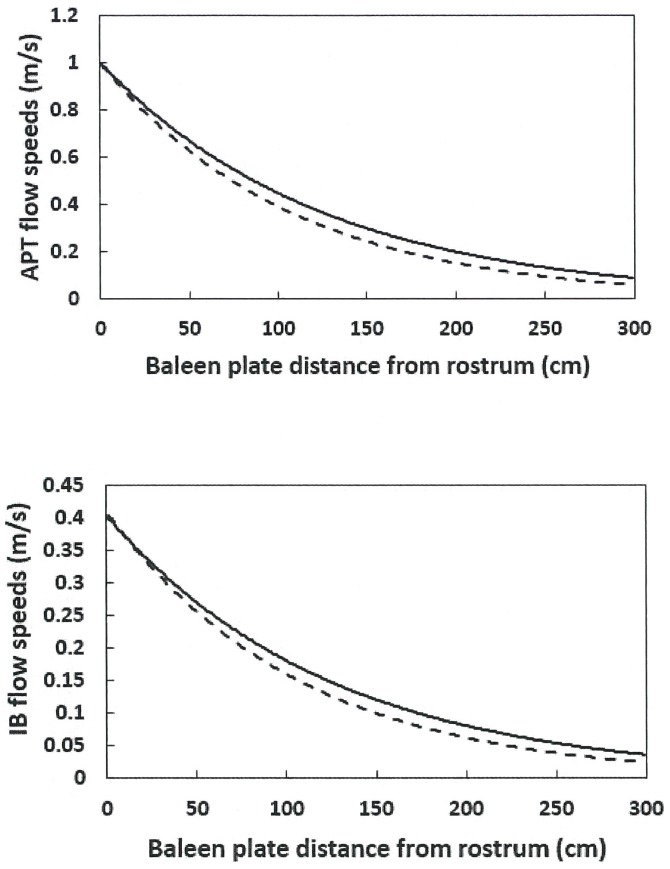
BHC flow speeds versus body size.Shown are values corresponding to body lengths of 10m (continuous line) and 15m –case A (dashed line). Both cases with simulated with Uwhale = 1.0m/s and C = 0.40. At a 10m-length, dbaleen = 0.01m, cbaleen = 0.07m, hHT = 1.5m and Din = 0.5m; and at 15m, dbaleen = 0.015m, cbaleen = 0.105m, hHT = 2.6m and Din = 0.65m.